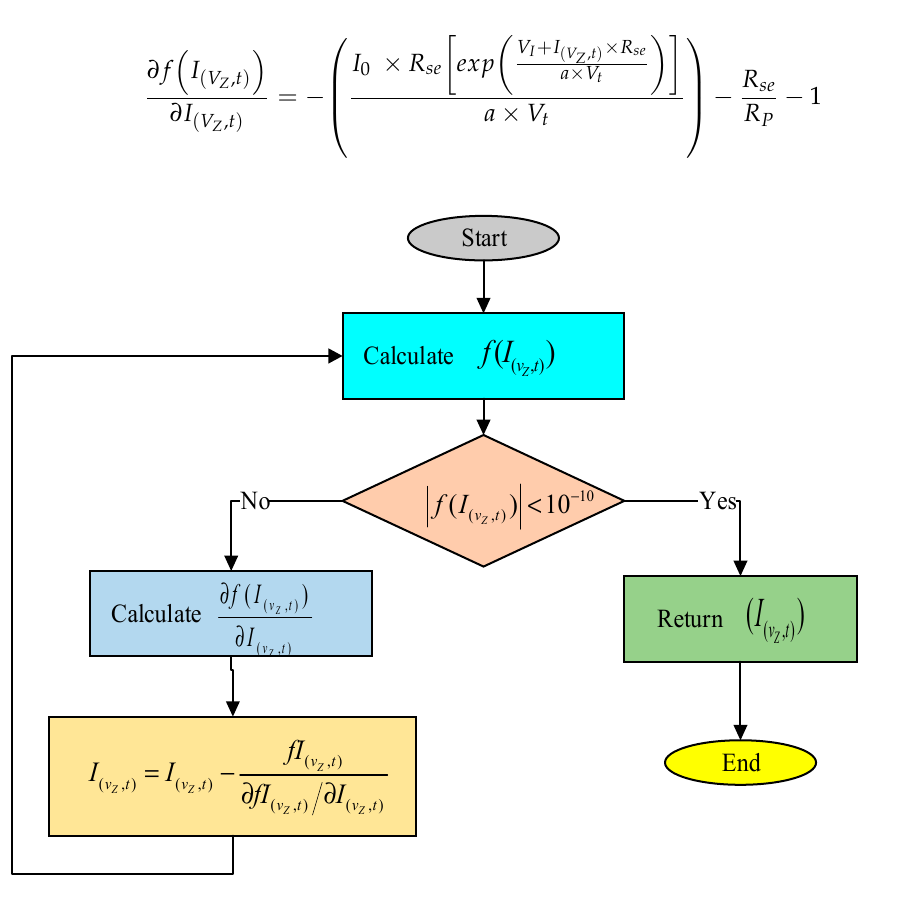
Table 1. Bounds of SDM for three different case studies.